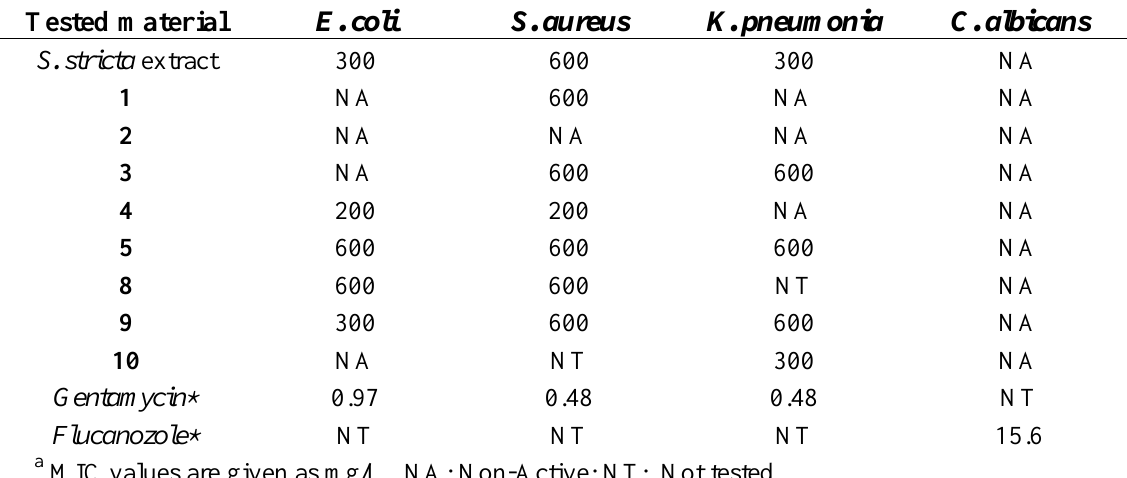
Table 1. Antibacterial and antifungal activity of acetone extract of S. stricta and kaurene diterpenoids. Tested